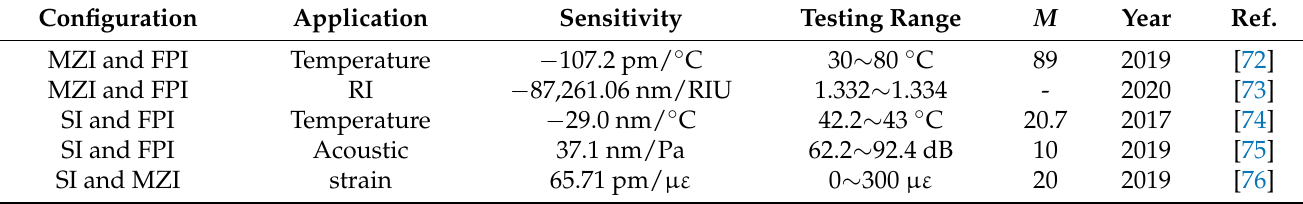
Table 3. Summary of the Vernier effect fiber sensors based on hybrid